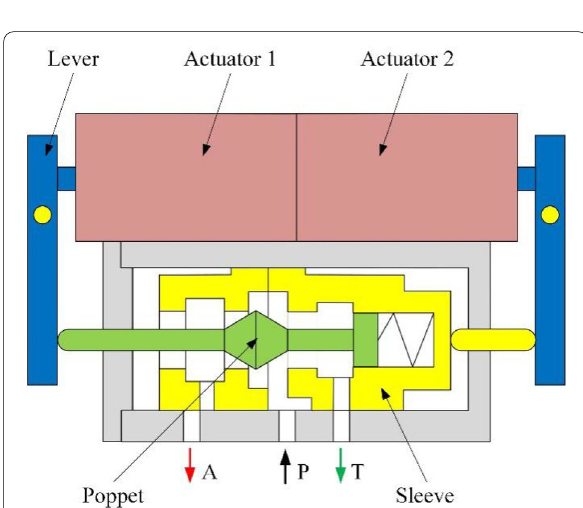
Figure 16 Poppet valve with two giant magnetostrictive actuators developed by Shi et al.